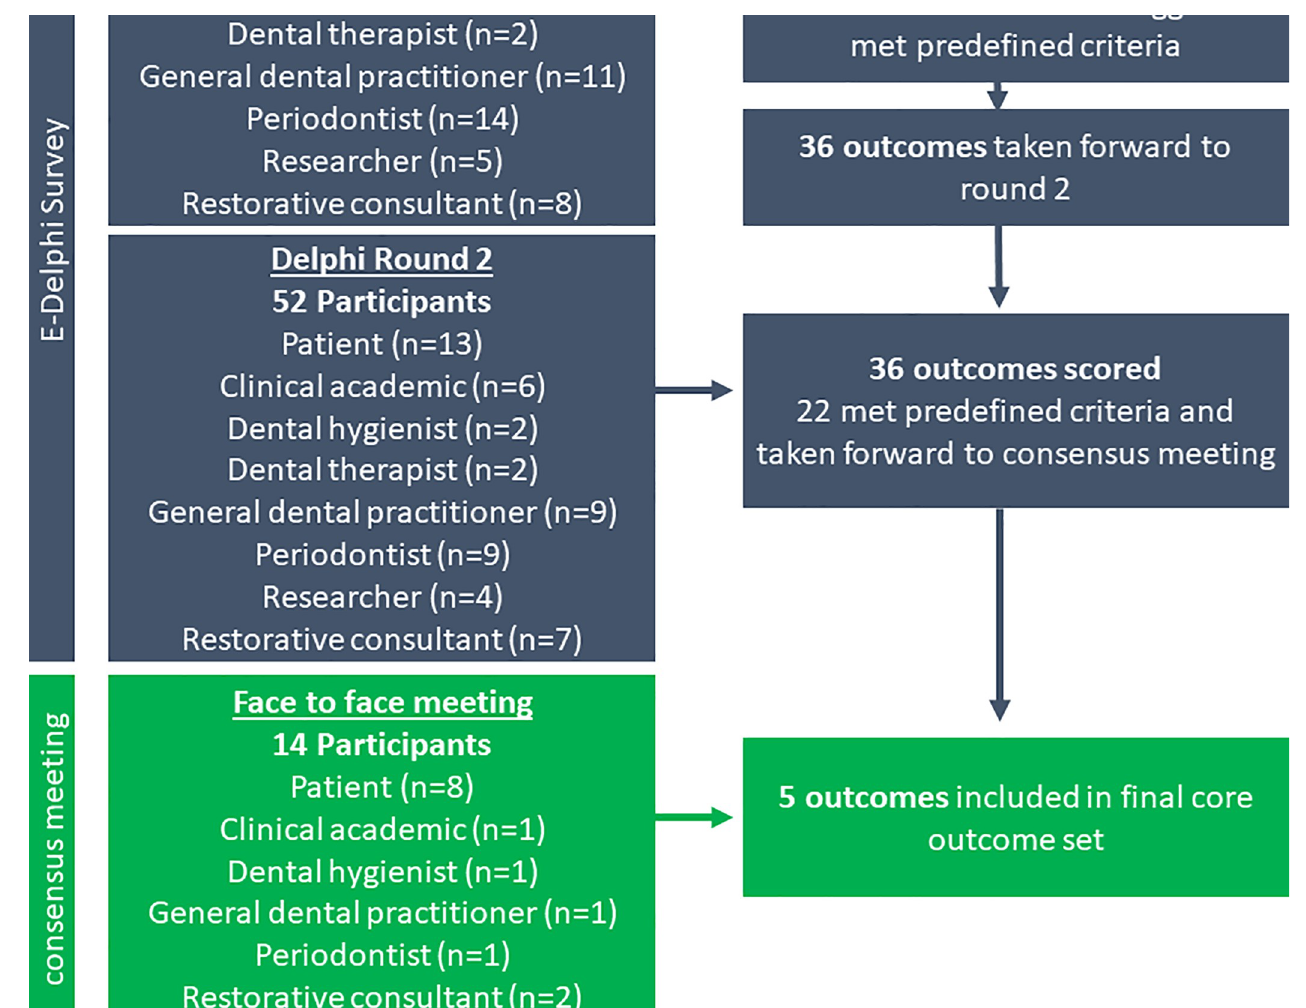
Fig 1. Flow diagram overview of overall core outcome set